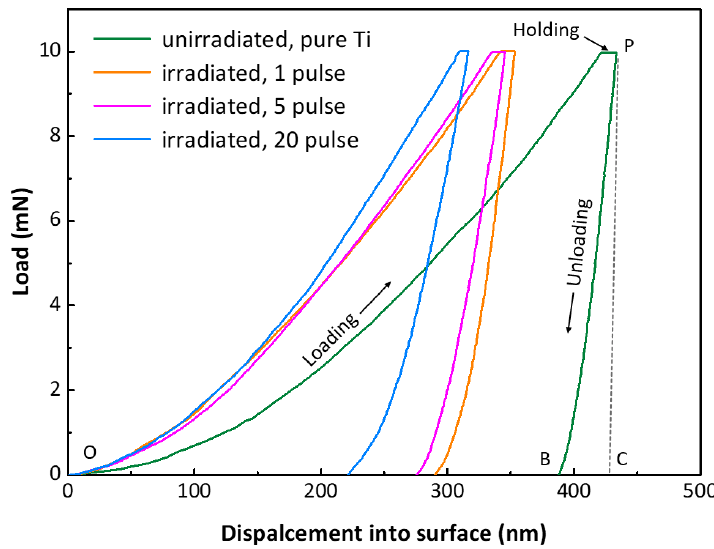
Figure 11. Load-displacement curves of the pure Ti sample and the Ti-Cr alloy coating samples with different pulses of irradiation.